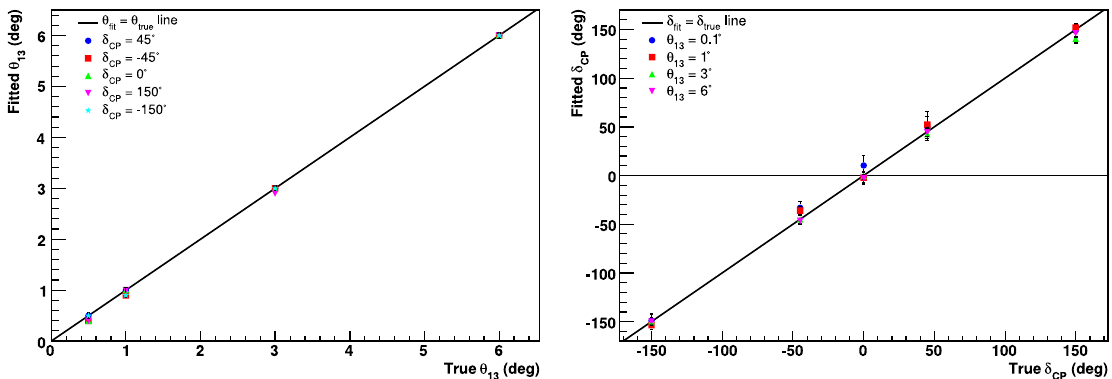
FIG. 22. Quality of fit to (cid:1) (left) and (cid:2) (right) for a range of values, using the near-far projection method. 13